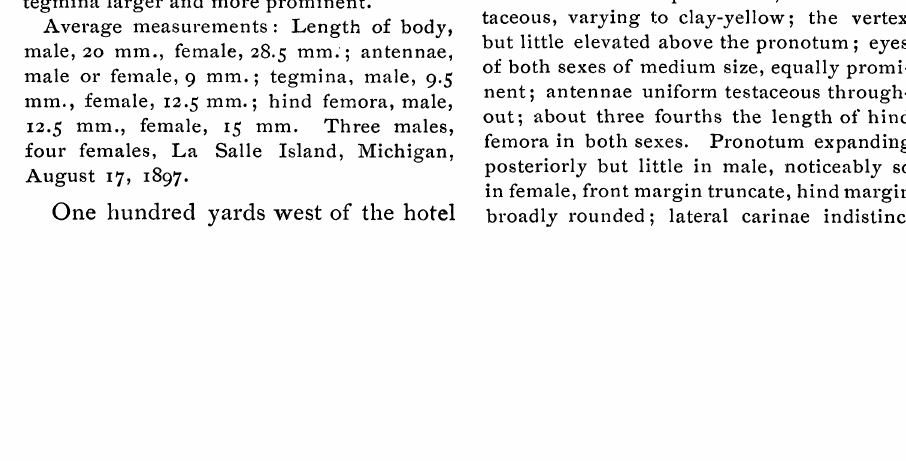
sexes. Pronotum distinctly enlarging poste- riorly (especially so in female) the disk fuscous or testaceous flecked with fuscous; the posterior lobe darkest; the lateral lobes with a post ocular piceous band on their upper half which extends to the metazona, the lower half testaceous lateral carinae distinct but not prominent; the median carina sharp and distinct on the metazona, dull and indis- tinct on the prozona; front margin truncate, hind margin subangulate. Tegmina a little more than twice as long as ptonotum, over- lapping, sublanceolate, the dorsal and lateral fields angularly separated, brownish, flecked with fuscous, which along the median line of the lateral field is more or less aggregated into a row of small quadrangular spots. Hind femora stout, testaceous, faintly bifas- ciate with fuscous, the black of geniculation bordered proximally by a yellowish ring, the inferior face a bright blood-red; hind tibiae blood-red, the spines black except at